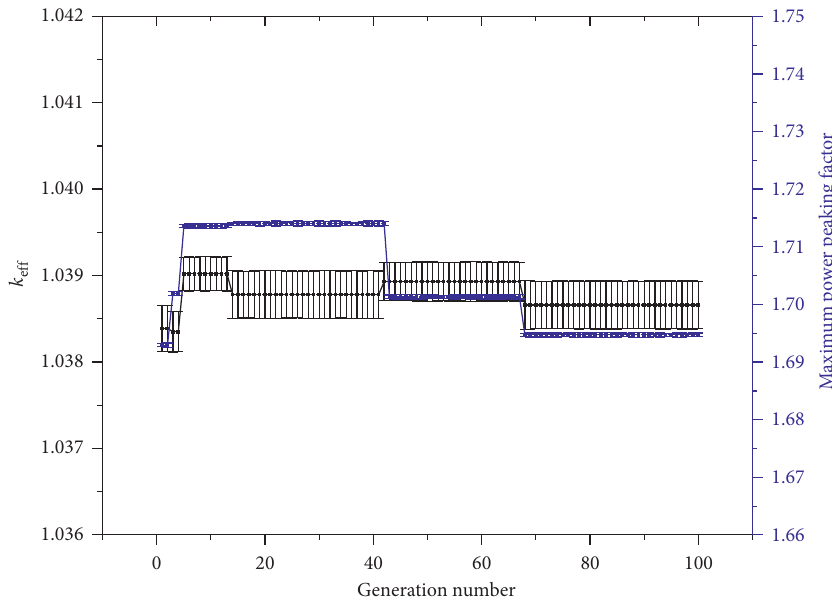
Figure 7: Comparison of converged optimal solution of the maximum k